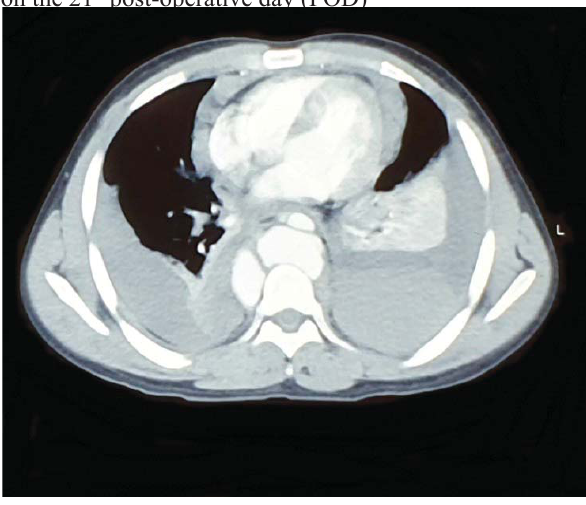
Figure 1. CECT chest showing contrast extravasation from DTA with bilateral hemothorax